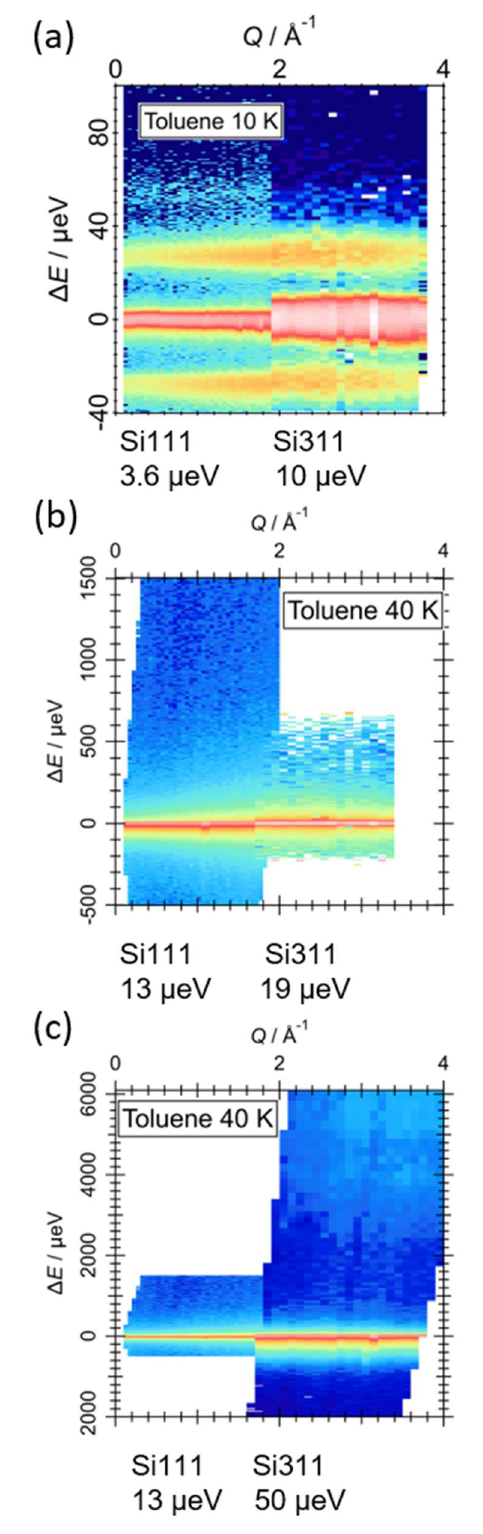
Fig. 5. The QENS spectra for solid toluene at 10 K and 40 K with various energy resolutions obtained with Si111 and Si311. (a) The combination of 3.6 μeV for Si111 (225 Hz, 3 cm × 3 cm slits) and 10 μeV for Si311 (300 Hz, 1 cm × 1 cm slits), (b) the combination of 13 μeV for Si111 (without PSC) and 19 μeV for Si311 (300 Hz, 3 cm × 3 cm slits), and (c) the combination of 13